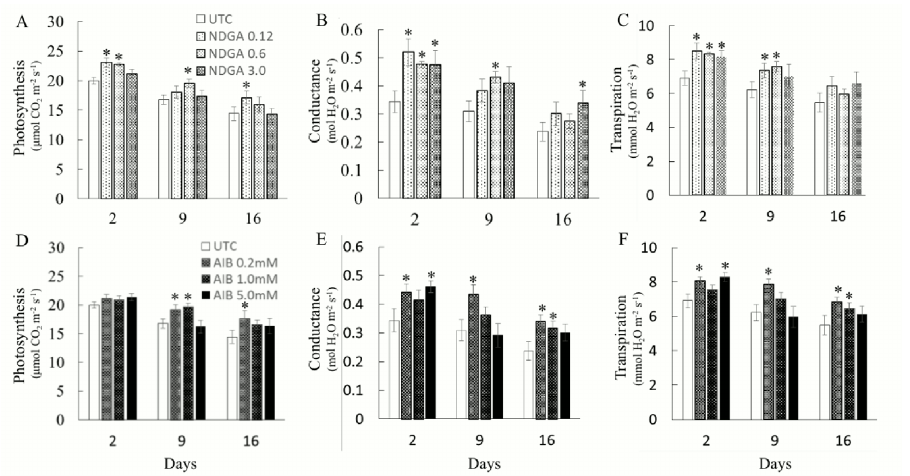
Fig 1. Effects of ABA and Ethylene biosynthesis inhibitors on photosynthesis, conductance, and transpiration rates at pre-anthesis. Photosynthesis rate (A, D), Conductance (B, E), and Transpiration rate (C, F) of UTC and NDGA treated plants (A, B, C) or UTC and AIB treated plants (D, E, F) 2, 9, and 16 d after spray at pre-anthesis stage. Values are Mean ± SE (n = 6). * indicating significance at P (cid:3) 0 . 05